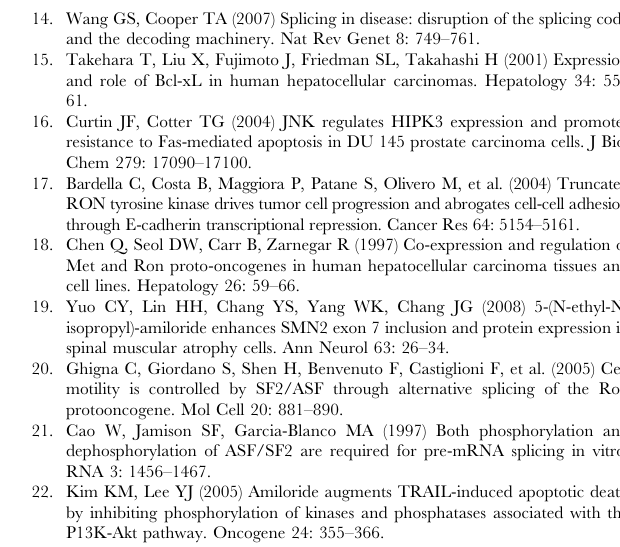
Figure S1 Effects of PI3K pathway inhibitors on SF2/ ASF and isoforms of HIPK3 and BCL-X in Huh-7 cells.